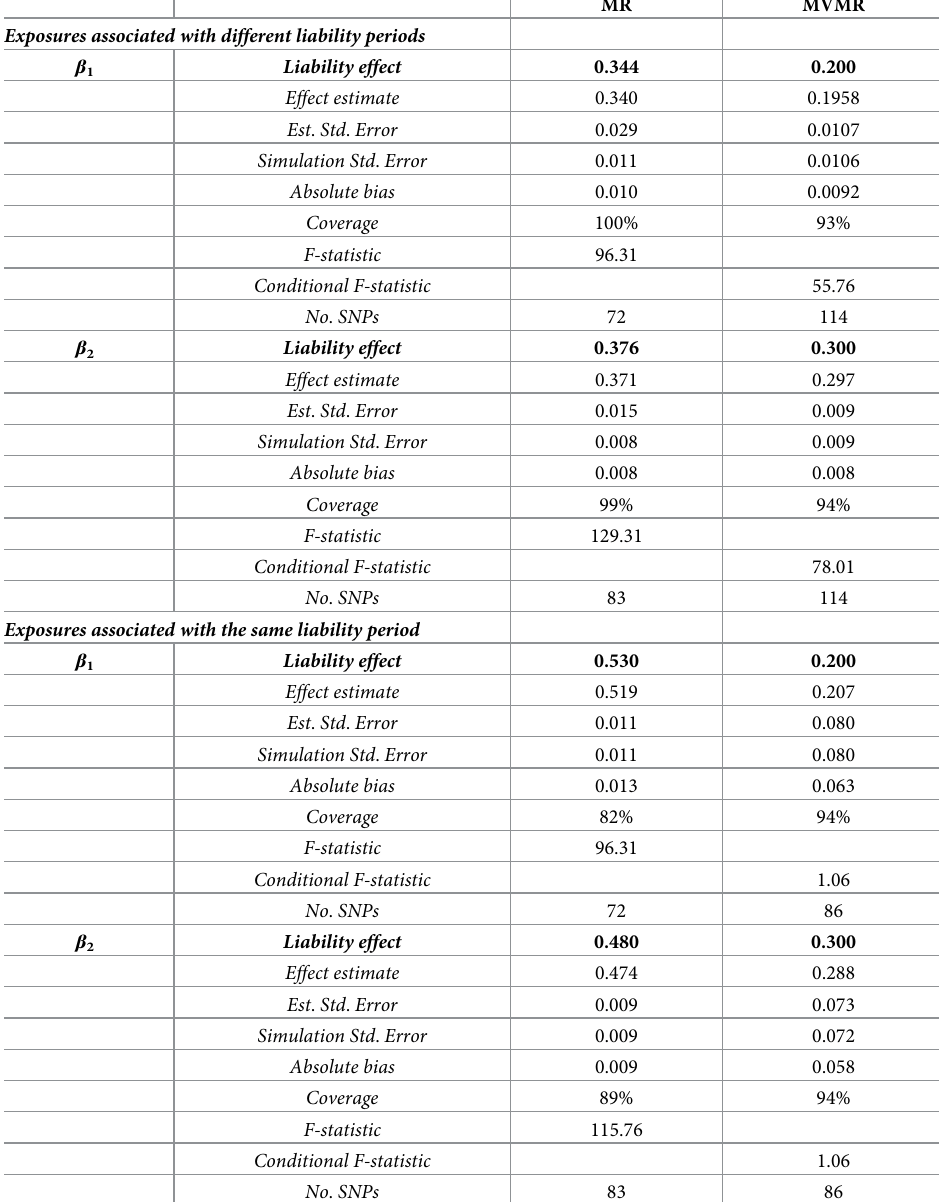
Table 1. Simulation results under different relationships between the genetic variants and the exposure at each time